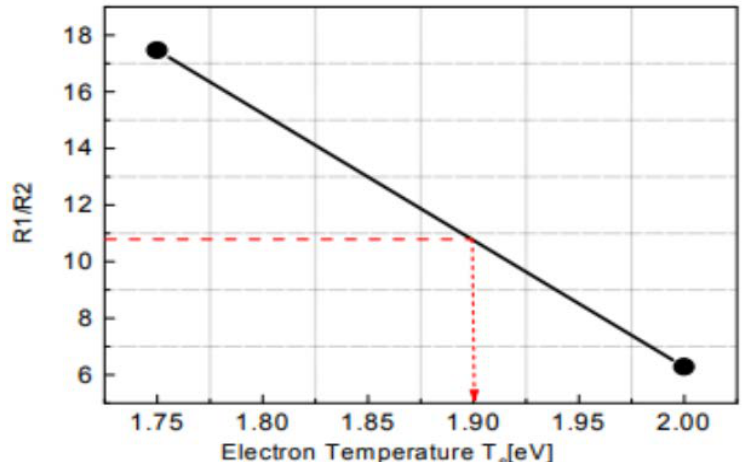
Fig.3: The plot between R